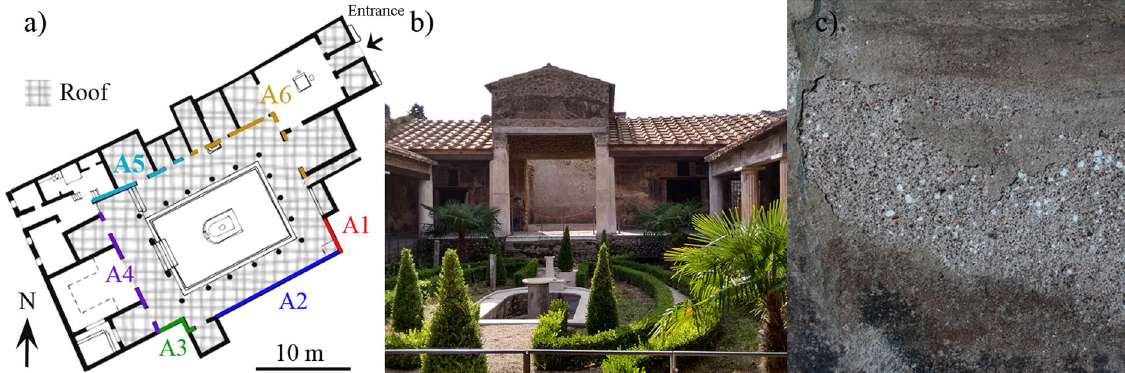
Figure 1. ( a ) Plan of the House of Gilded Cupid (Pompeii) showing the different measured areas (A1-A6). ( b ) Recent photograph of the wooden roof dated from 2004 that covers the wall paintings of the peristyle. ( c ) Detail of the sub-efflorescences formed in the intonaco in one of the studied